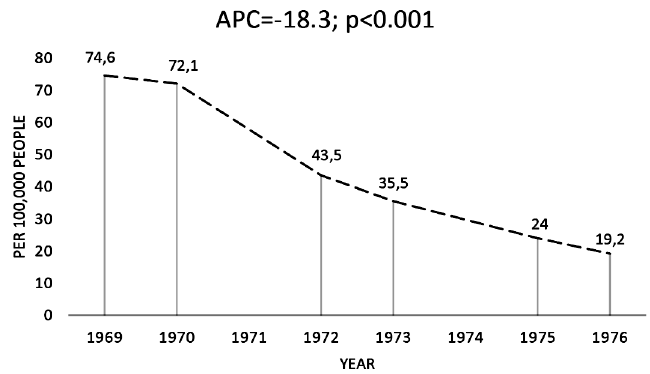
Figure 5. Syphilis incidence rates in the years 1969–1976 Throughout the following years (1976–1998), the constant downward trend continued (Figure 6), it was slightly less pronounced, but still statis-